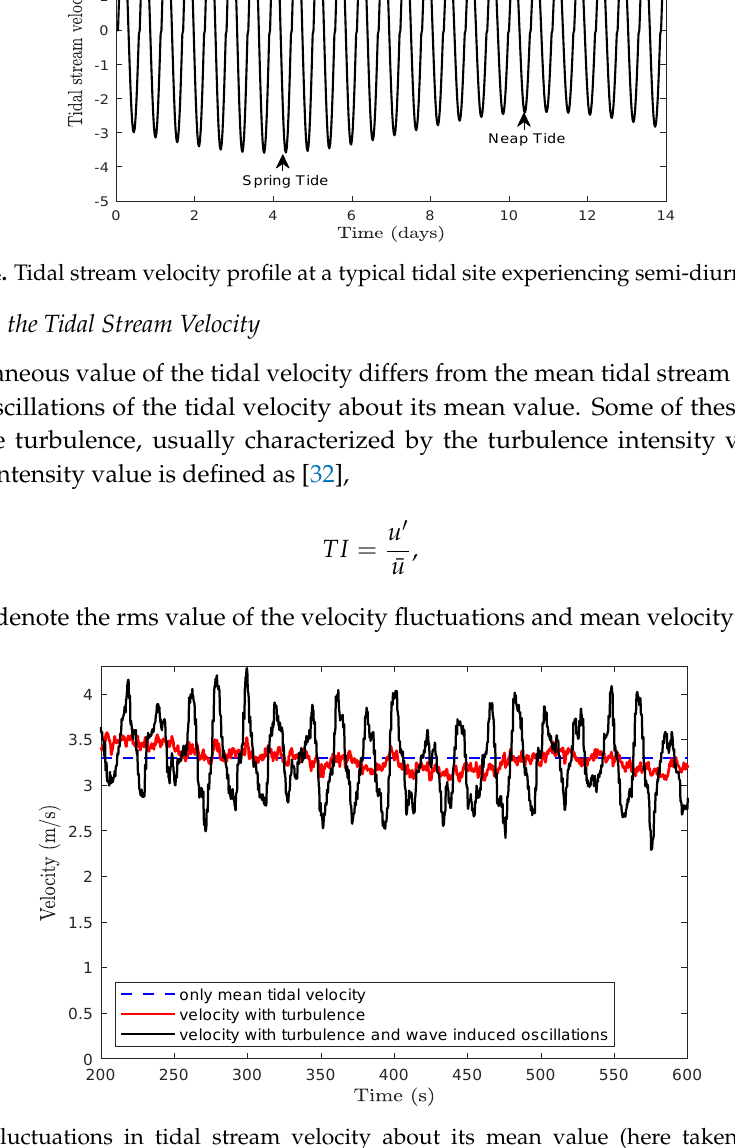
Figure 5. Fluctuations in tidal stream velocity about its mean value (here taken as 3.3 m/s) as a consequence of turbulence and wave induced